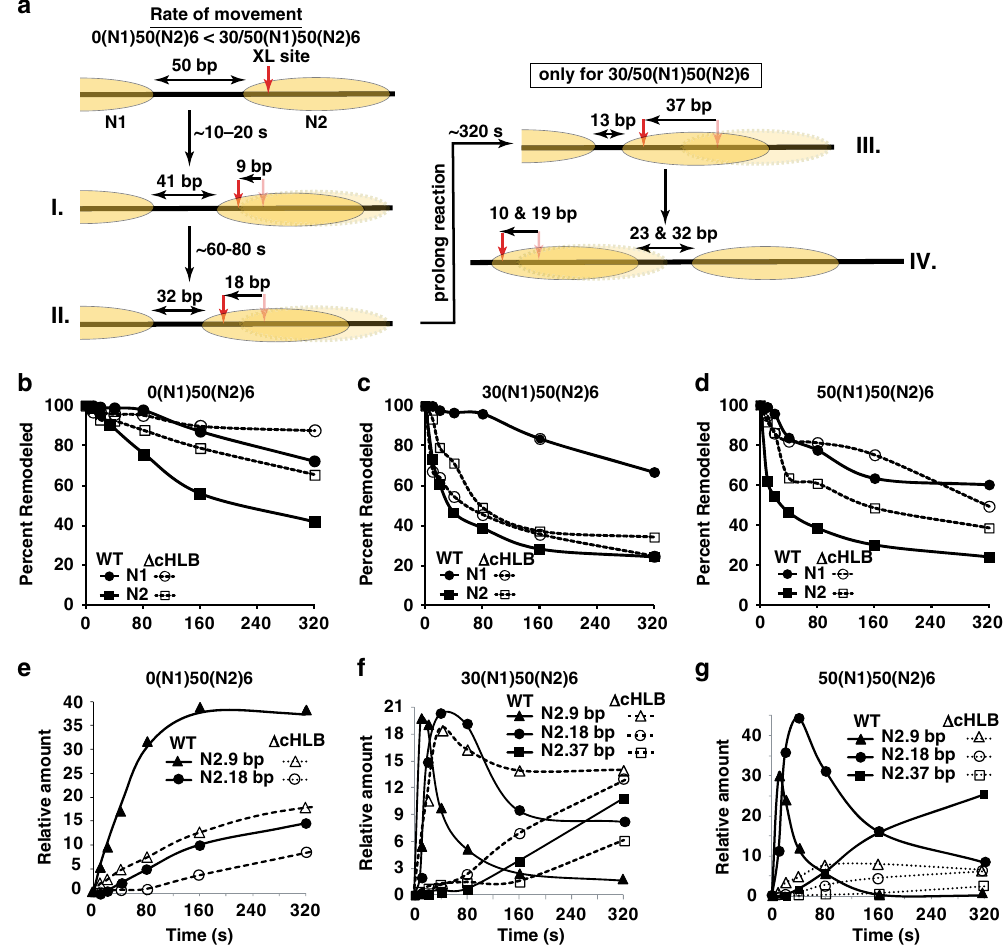
Fig. 7 In dinucleosomes, ISW1a is prone to move nucleosome N2 towards N1 and is blocked by truncation of the HLB domain. a Schematics show the time course for high-resolution tracking of DNA movement during ISW1a remodeling and spacing of dinucleosomes. Nucleosome movement was tracked by attaching a photoreactive reporter to residue 54 of histone H2B (red arrow) and following where it crosslinks to DNA as dinucleosomes are remodeled. The N1 and N2 nucleosomes are depicted as light tan ellipses. b – d The extent to which the initial DNA contact is reduced, as observed by loss of DNA crosslinking, was plotted versus time of remodeling for both the N1 (circles) and N2 (squares) nucleosomes. Remodeling was either with wild-type (closed symbol) or Δ cHLB (open symbol) ISW1a. e – g There are distinct distances to which nucleosomes are moved by ISW1a as detected by crosslinking that were quantitated and plotted versus time for wild type (closed symbol) or Δ cHLB (open symbol) ISW1a. The 9 (triangle), 18 (circle) and 37 bp (square) movement were plotted for N2 nucleosome movement and the type of dinucleosome used is shown above each plot. These experiments had a minimum of three replicates with similar results as those depicted. Source data are provided as a Source Data fi